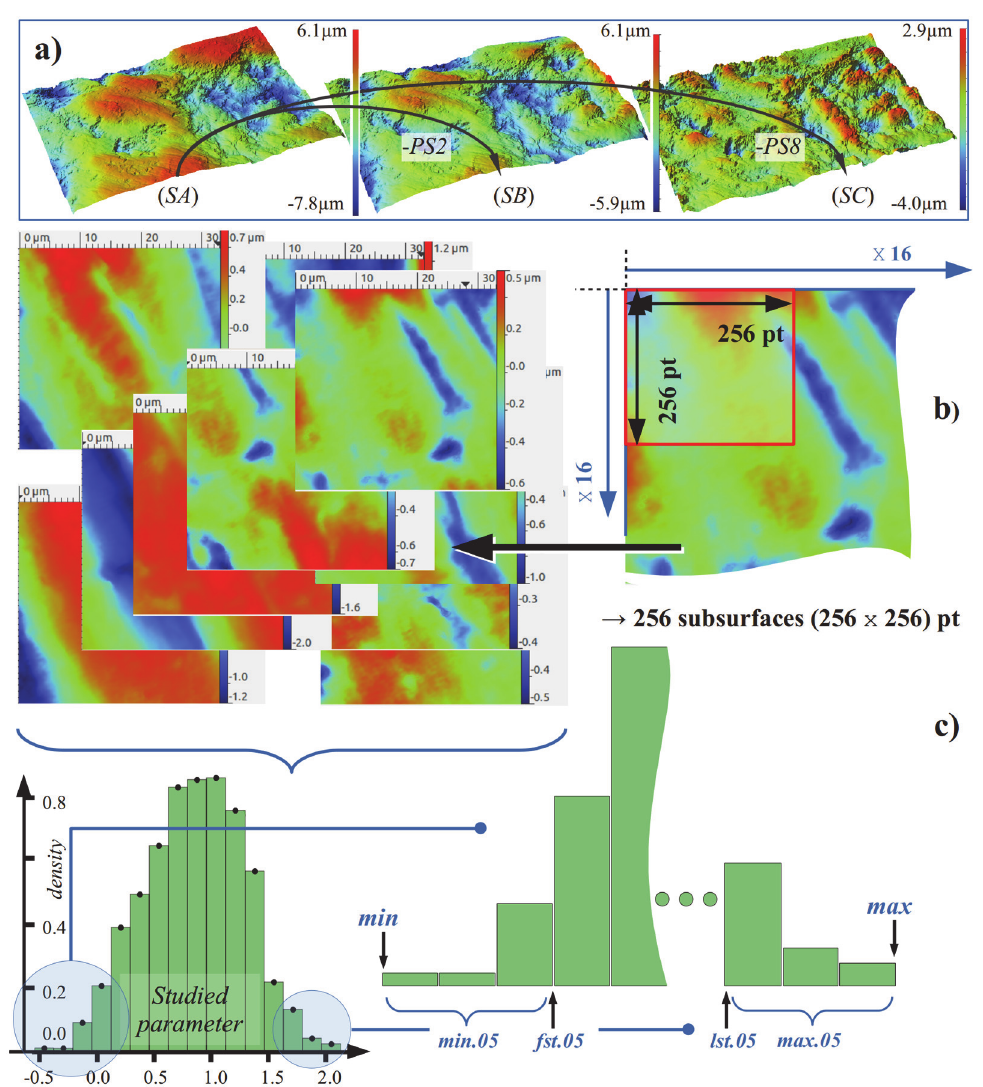
Figure 1 . The surface roughness enhancement ( a ): owing to the fact that SA embeds a macro geometry that hides the dietary signals, a second and an eighth order polynomial are subtracted; ( b ) SB and SC are uniformly sampled with 256 × 256 px surfaces; and, ( c ) Statistics are deduced from the set of 256 samples.